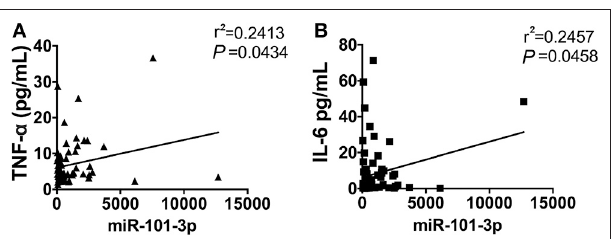
FIGURE 5 | The correlation of miR-101-3p with serum IL-6 and TNF- α . Correlation analysis of miR-101-3p with serum levels of (A) IL-6 and (B) TNF- α in AOSD